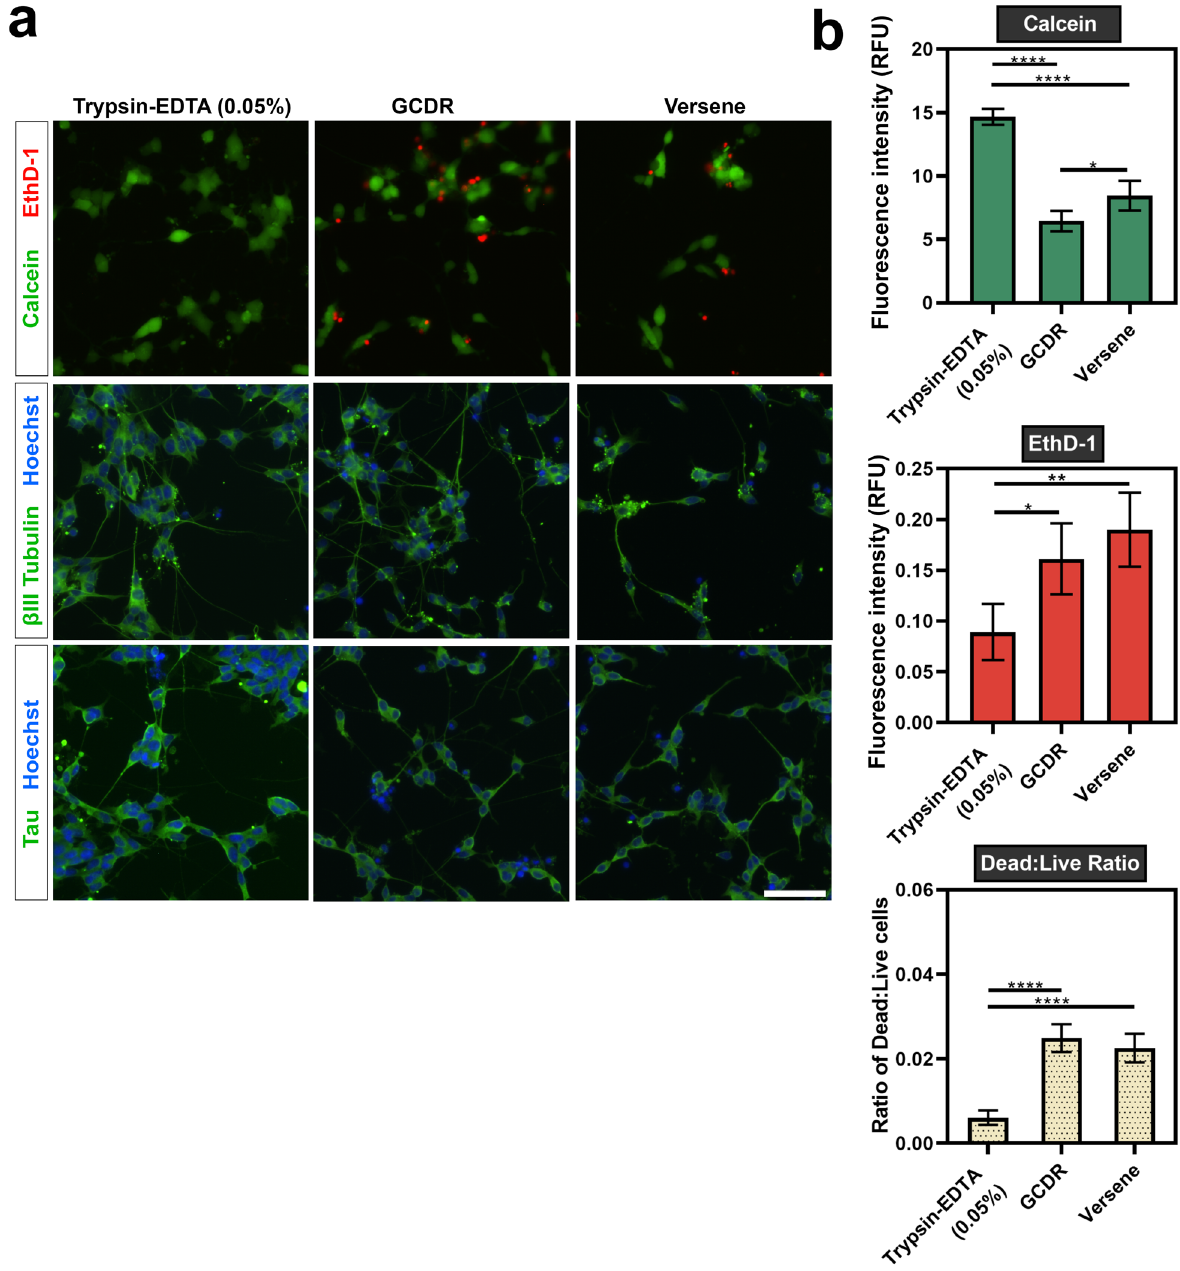
Figure 4. Detachment and re-plating of differentiated SH-SY5Y cells. Terminally differentiated SH-SY5Y cells were re-plated using trypsin–EDTA (0.05%), GCDR or versene and assessed for viability and expression of neuronal markers 48 h after re-plating. ( a ) Microscopic images of calcein (live) and EthD-1 (dead) labelled cells. Images were acquired using an EVOS FL Auto microscope with a ×20 objective lens (scale bar = 100 µm). βIII-tubulin images were acquired using the GFP filter (excitation 482/25 nm; emission 524/24 nm; exposure 110 ms), while Hoechst nuclei images were acquired using the DAPI filter (excitation 357/44 nm; emission 447/60 nm; exposure 19 ms). ( b ) Fluorescence emission of calcein and EthD-1 was measured to evaluate viability after re-plating. A one-way ANOVA test and Tukey’s post-hoc analysis was performed to evaluate statistical significance where **** p < 0.0001, *** p < 0.001, ** p < 0.01 and * p < formation of free-floating clusters of cells. As observed in the graphs presented in Fig. 4b [Left], the proportion of live cells, indicated by the calcein fluorescence emission, was around two times greater for cells detached with trypsin–EDTA (0.05%) (14.66 ± 0.62) compared to GCDR (6.44 ± 0.81) and Versene (8.44 ± 1.17). Similarly, trypsin–EDTA (0.05%) had almost half the proportion of dead cells, indicated by the EthD-1 emission, at a value of 0.0891 ± 0.028. For GCDR and Versene, these values were at 0.161 ± 0.035 and 0.190 ± 0.036, respectively. The